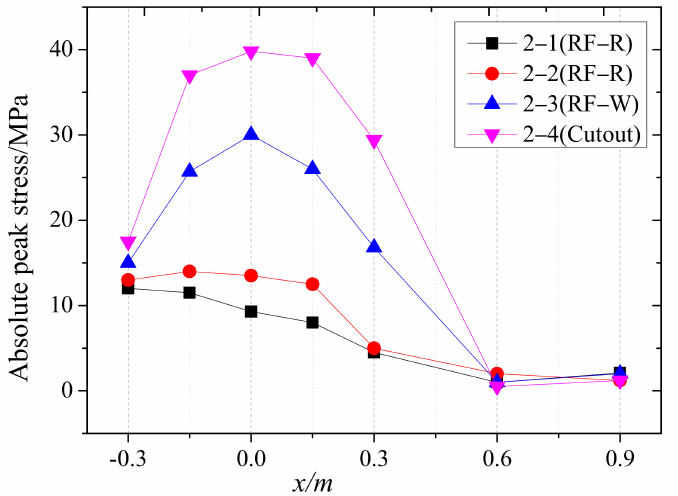
Figure 11. Peak stress at 2-1~2-4 versus distance to wheel